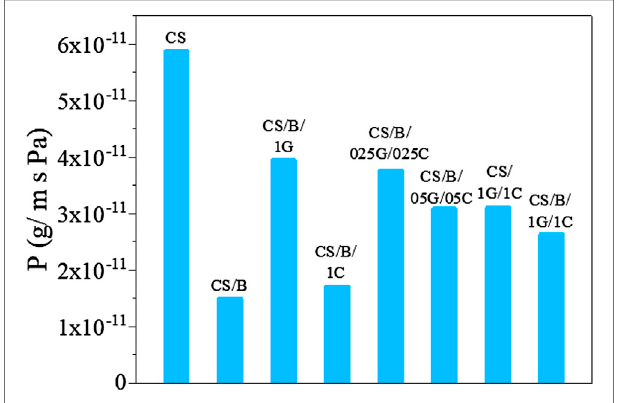
FIGURE 7 | Water vapor permeability of pristine CS and CS-based composite fi lms.